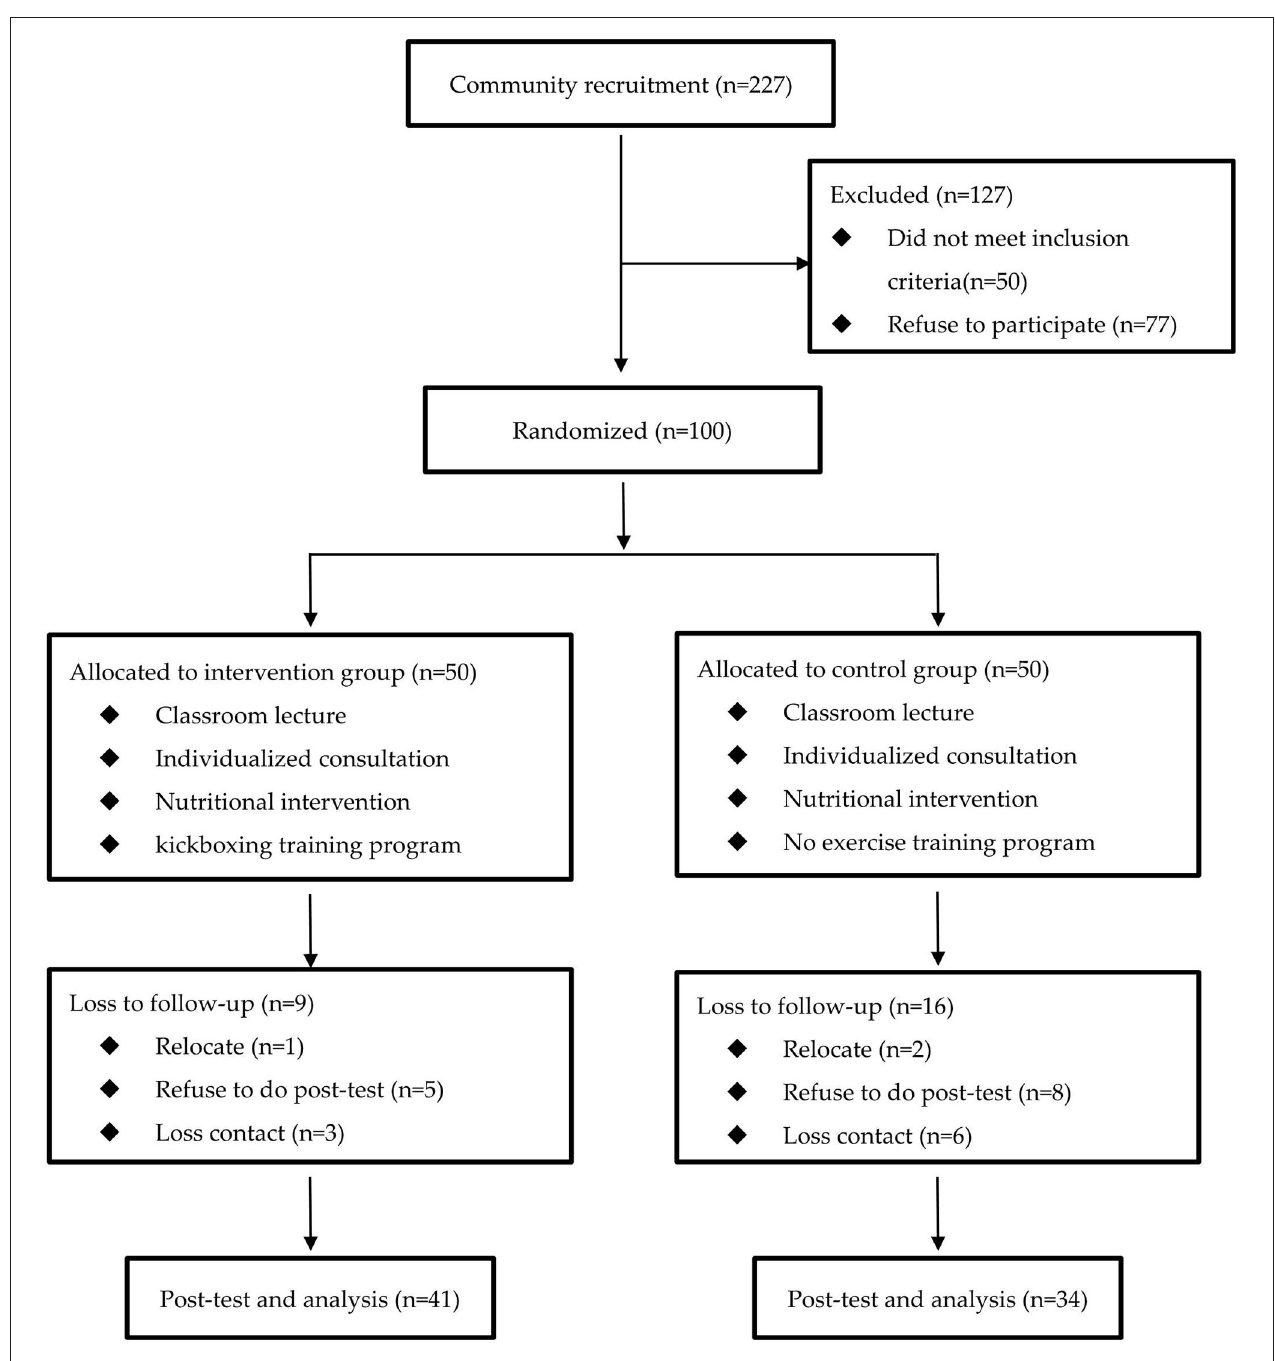
FIGURE 1 | Flow chart of participants who entered the study.